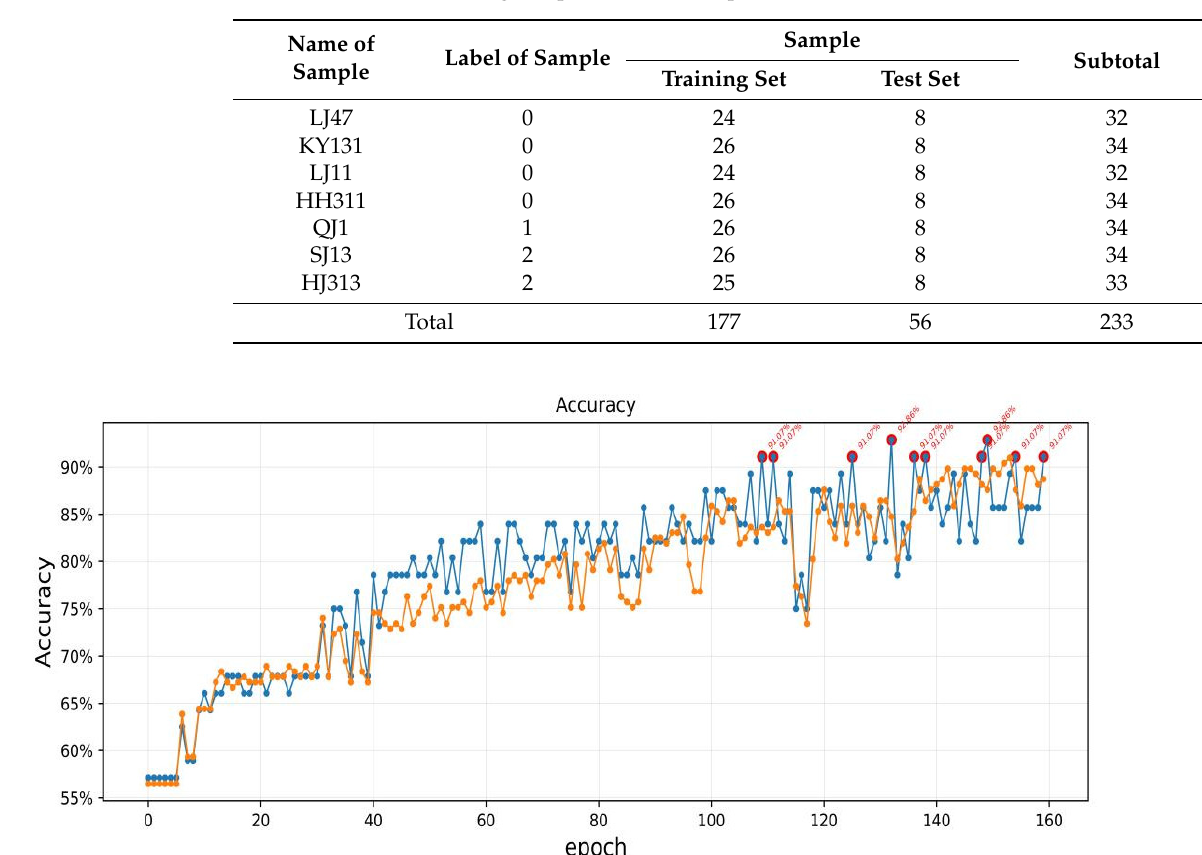
Table 3. The training cycles and loss function values with high accuracy were obtained by the Cap- sNets model.